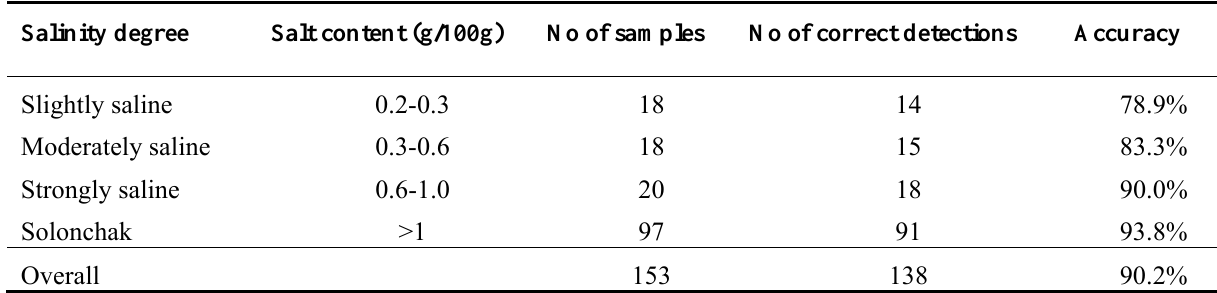
Table 2. Accuracy assessment using field sampling